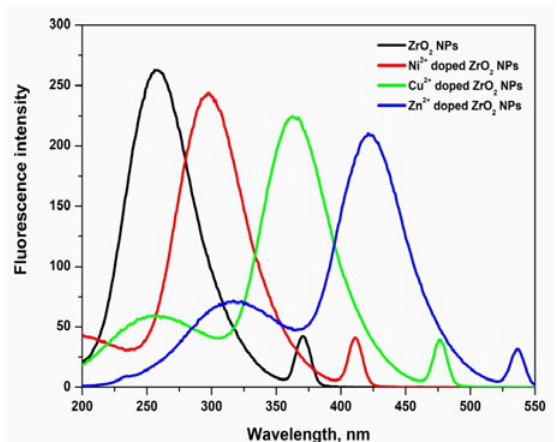
Fig. 1. The room temperature optical absorption spectrum of undoped and doped ZrO Fig. 1 The room temperature optical absorption spectrum of undoped and doped ZrO 2 NPs.